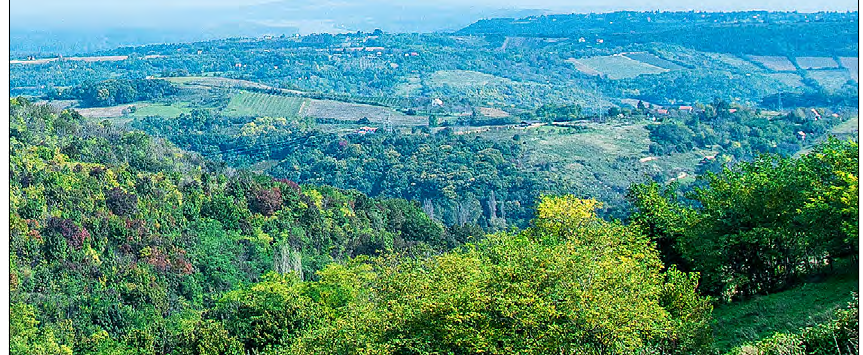
Figure 5. The forested slopes of the Fruska gora National park (landscape type) Source: Vojvodina Environmental Movement, Sremski